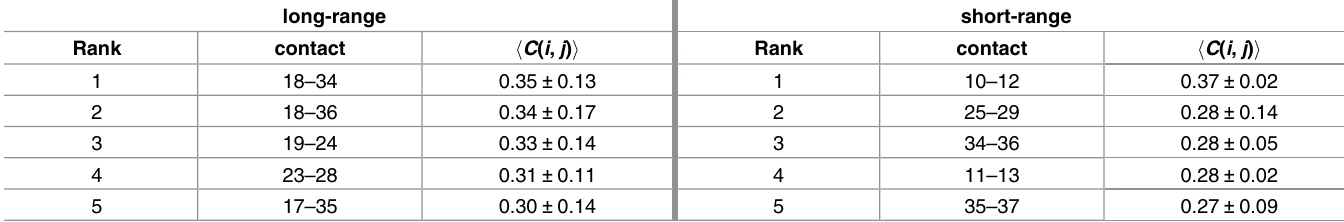
Table 6. Five top side chain contacts in A β 10-40peptide for OPLS-AA force